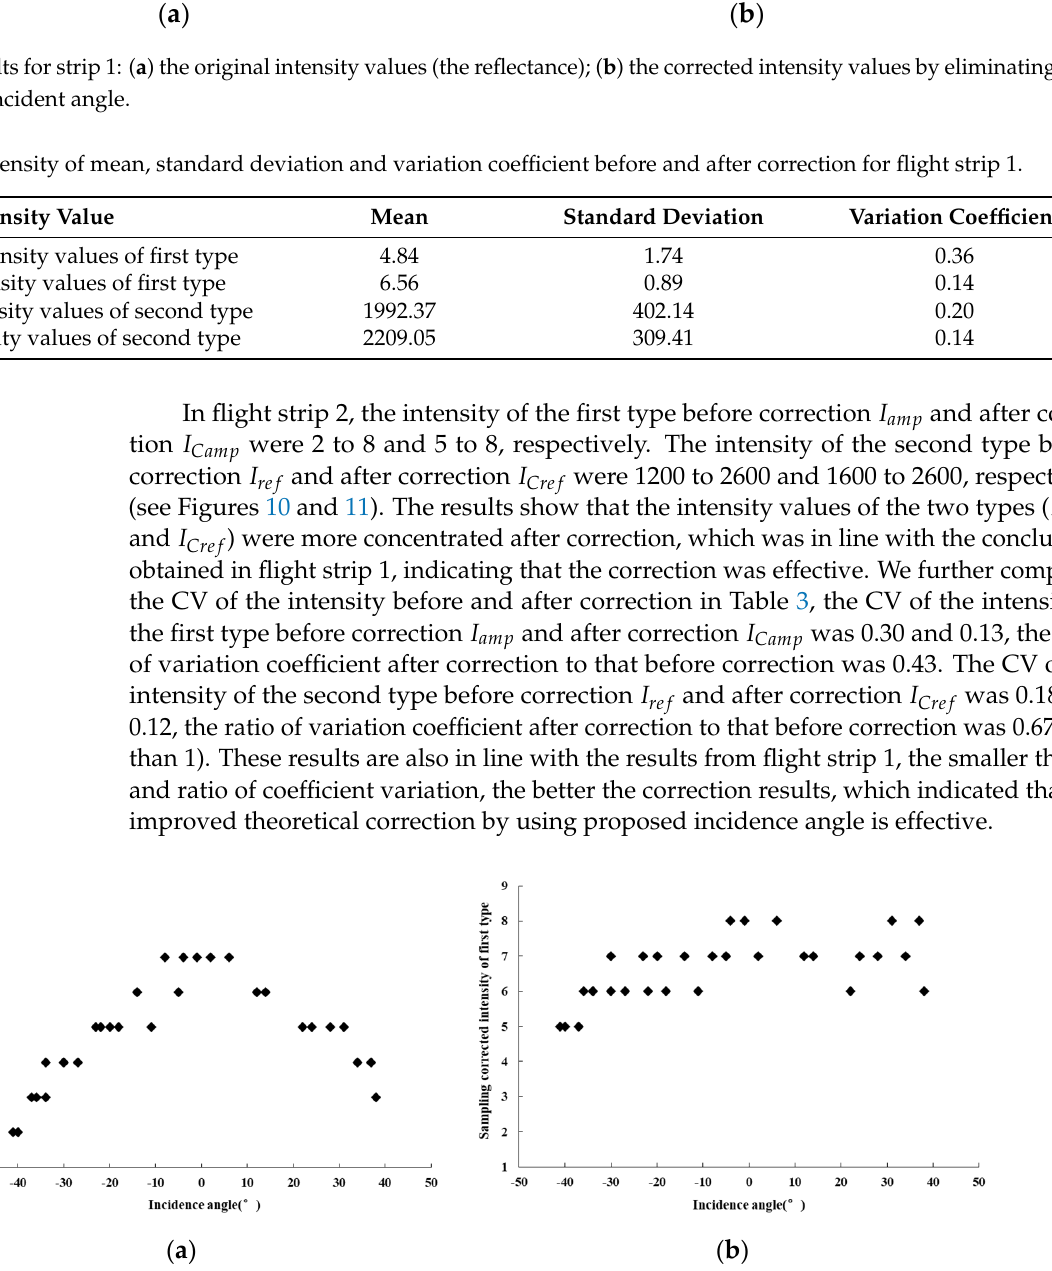
( b ) Figure 11. Results for strip 2: ( a ) the original intensity values (the reflectance); ( b ) the corrected intensity values by elimi- nating the effects of incident angle. Table 3. Intensity of mean, standard deviation, and variation coefficient before and after correction in flight strip 2. Intensity Value